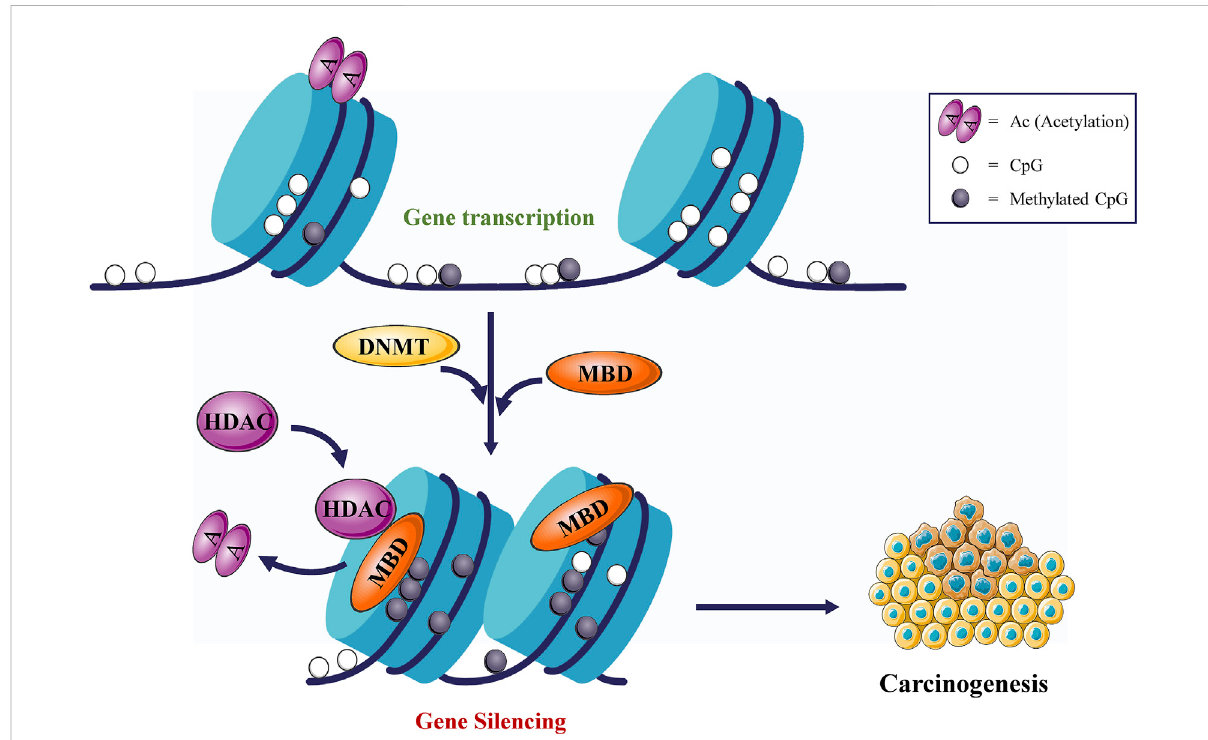
FIGURE 1 DNMTs promote tumorigenesis. DNMTs cause gene silencing and promote